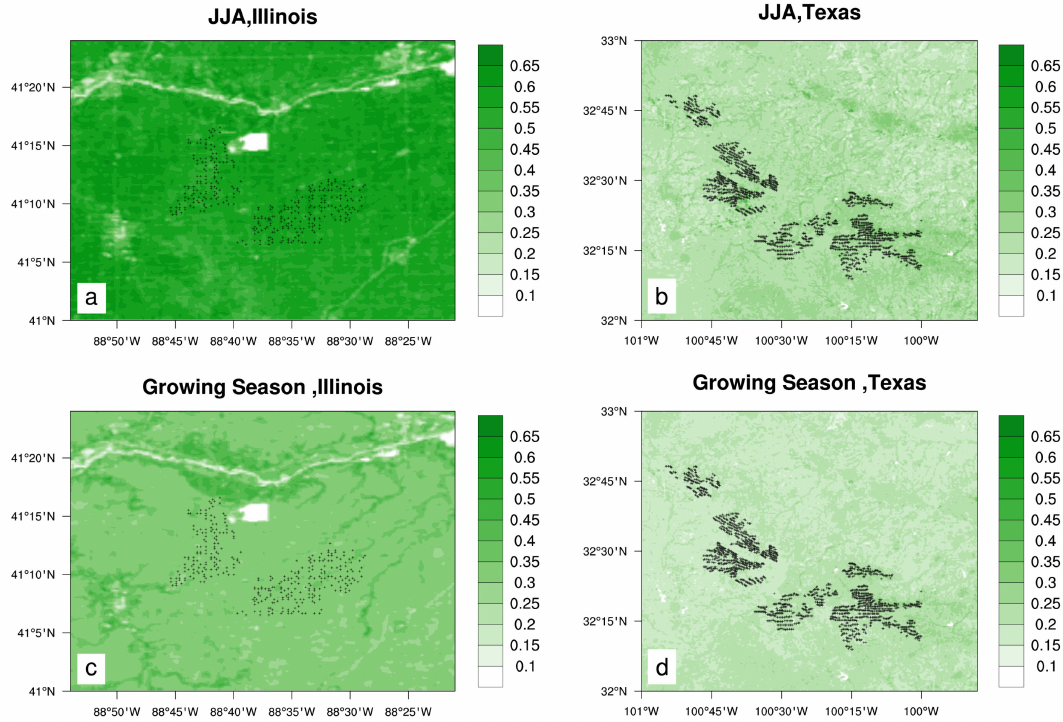
Figure 4. Spatial patterns of EVI climatology (2003–2014) during JJA and the growing season: ( a ) JJA in Illinois, ( b ) JJA in Texas, ( c ) the growing season in Illinois, ( d ) the growing season in Texas. The black dots indicate